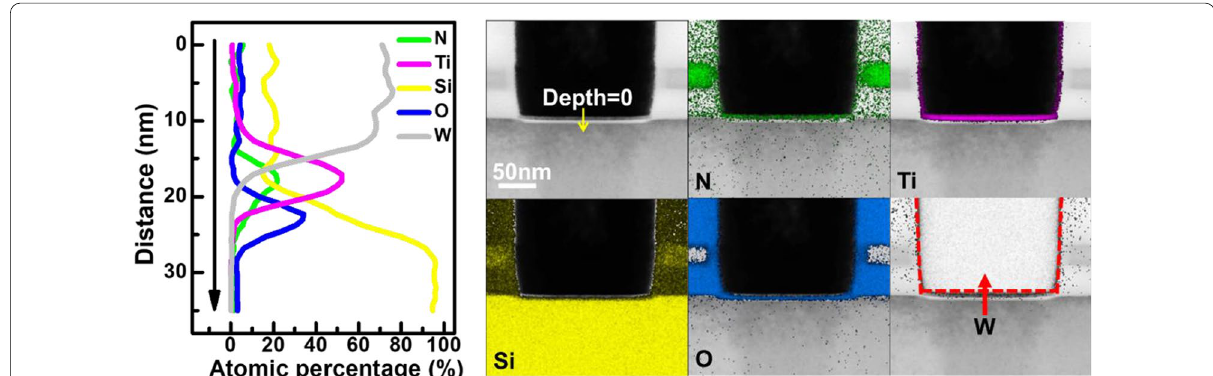
Fig. 3 EDX‑based composition analysis of TMO layer of BCRRAM cell. BCRRAM’s TMO layer is composed of TiN/TiON/SiO 2 stack